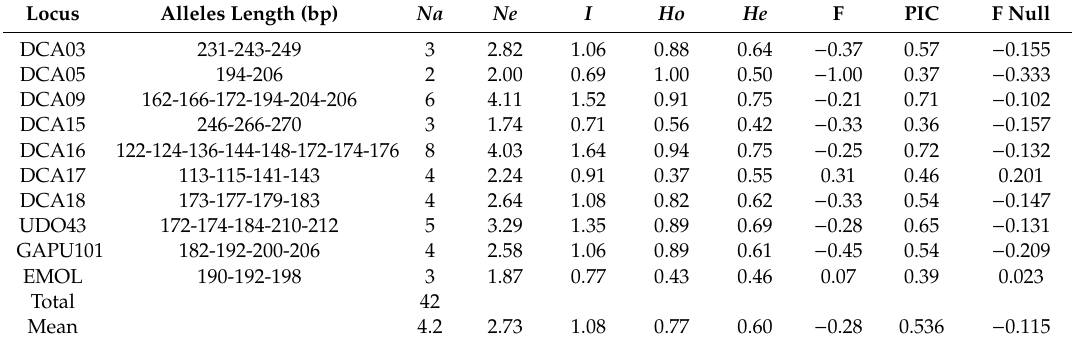
Table 1. Genetic diversity indices number of alleles ( Na ), e ff ective number of alleles ( Ne ), Shannon’s diversity index ( I) , observed heterozygosity ( Ho ), expected heterozygosity ( He ), fixation index (F), and PIC values revealed in the 37 olive Degache accessions analyzed with 10 SSR